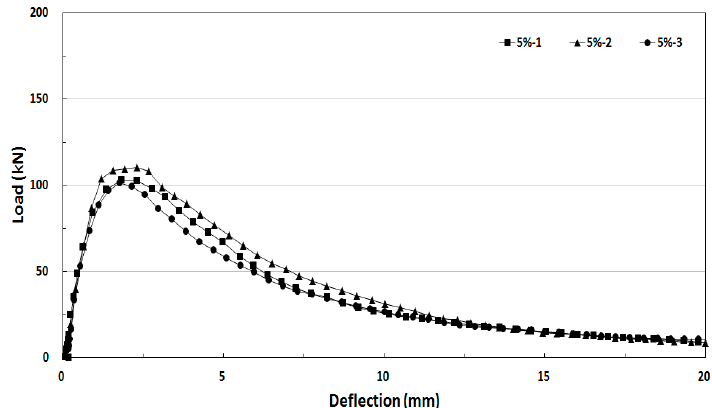
Figure 4. Load-mid span deflection curve at a fiber volume fraction of 5%.